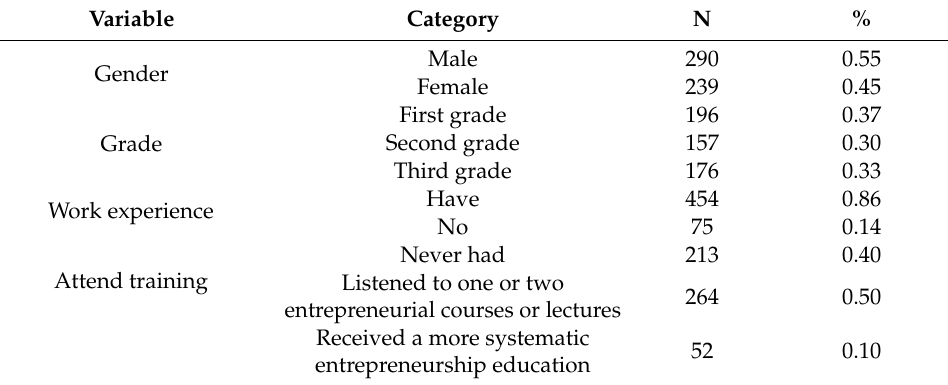
Table 3. Basic information of the